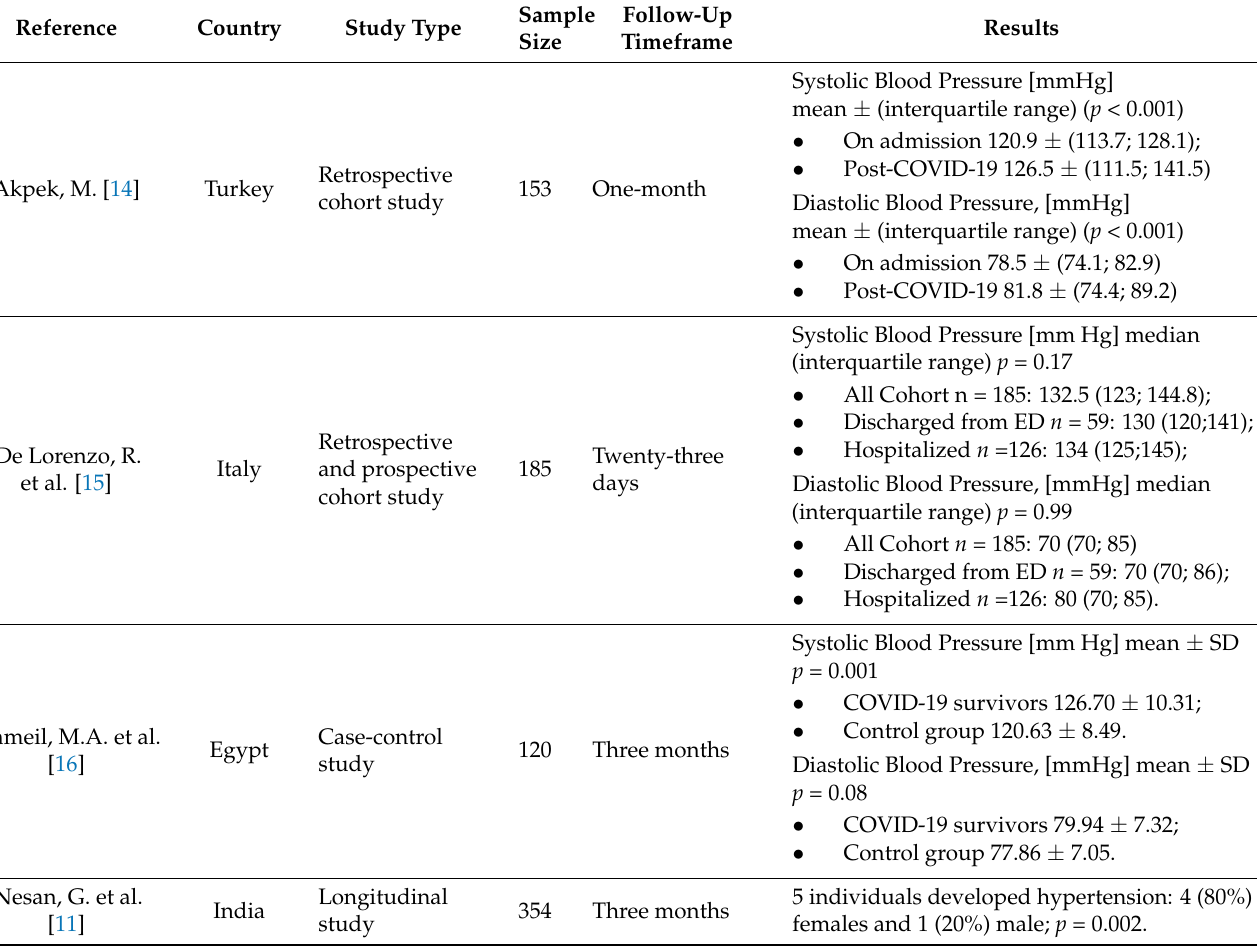
Table 2. Summary of studies investigating new-onset hypertension after COVID-19